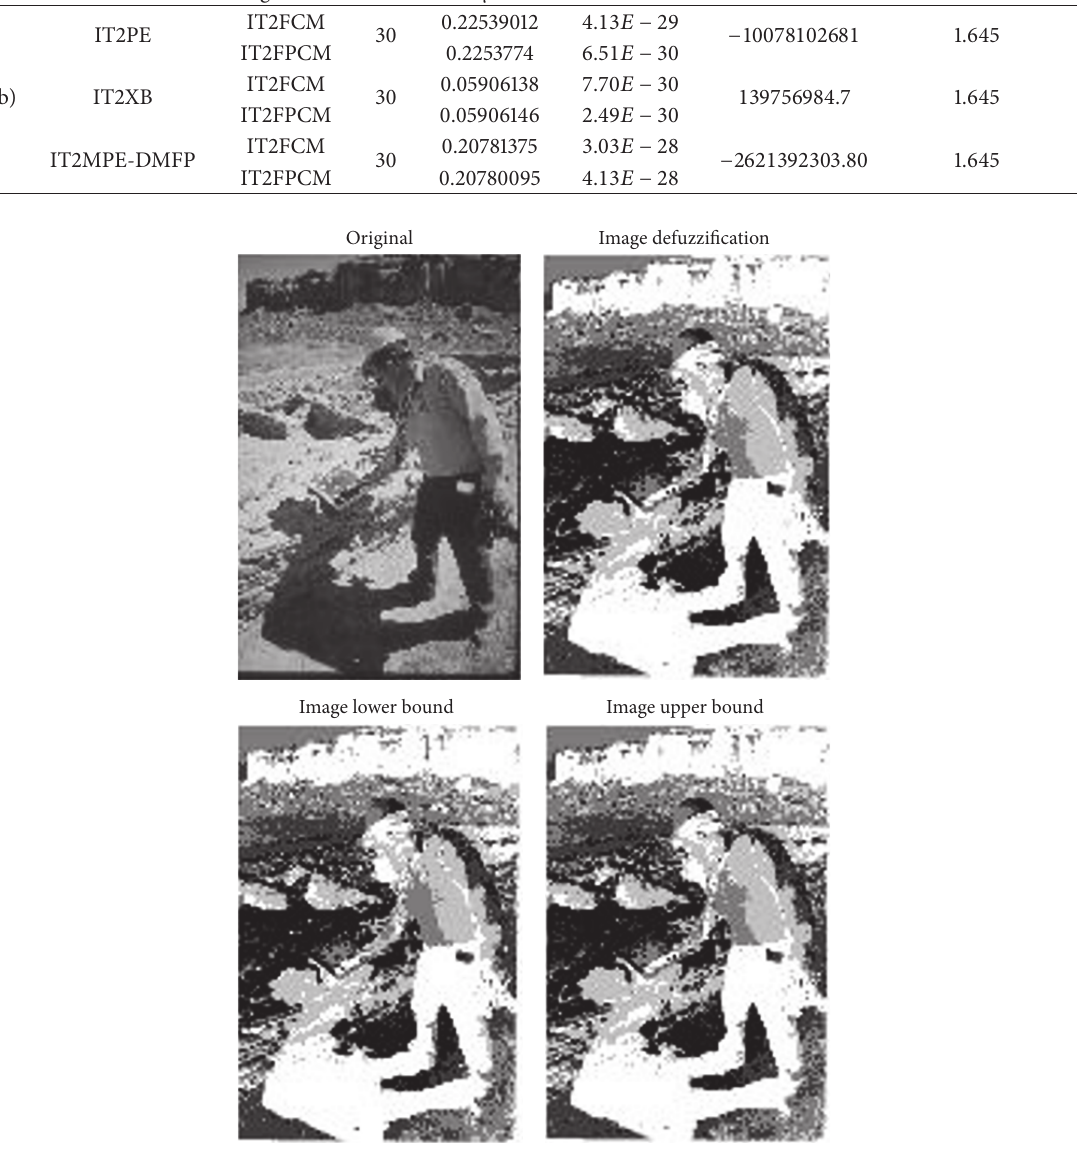
Figure 4: Resulting image clustering performed by the IT2FPCM algorithm for 5 clusters to Figure 2(b) because of the gray levels containing the